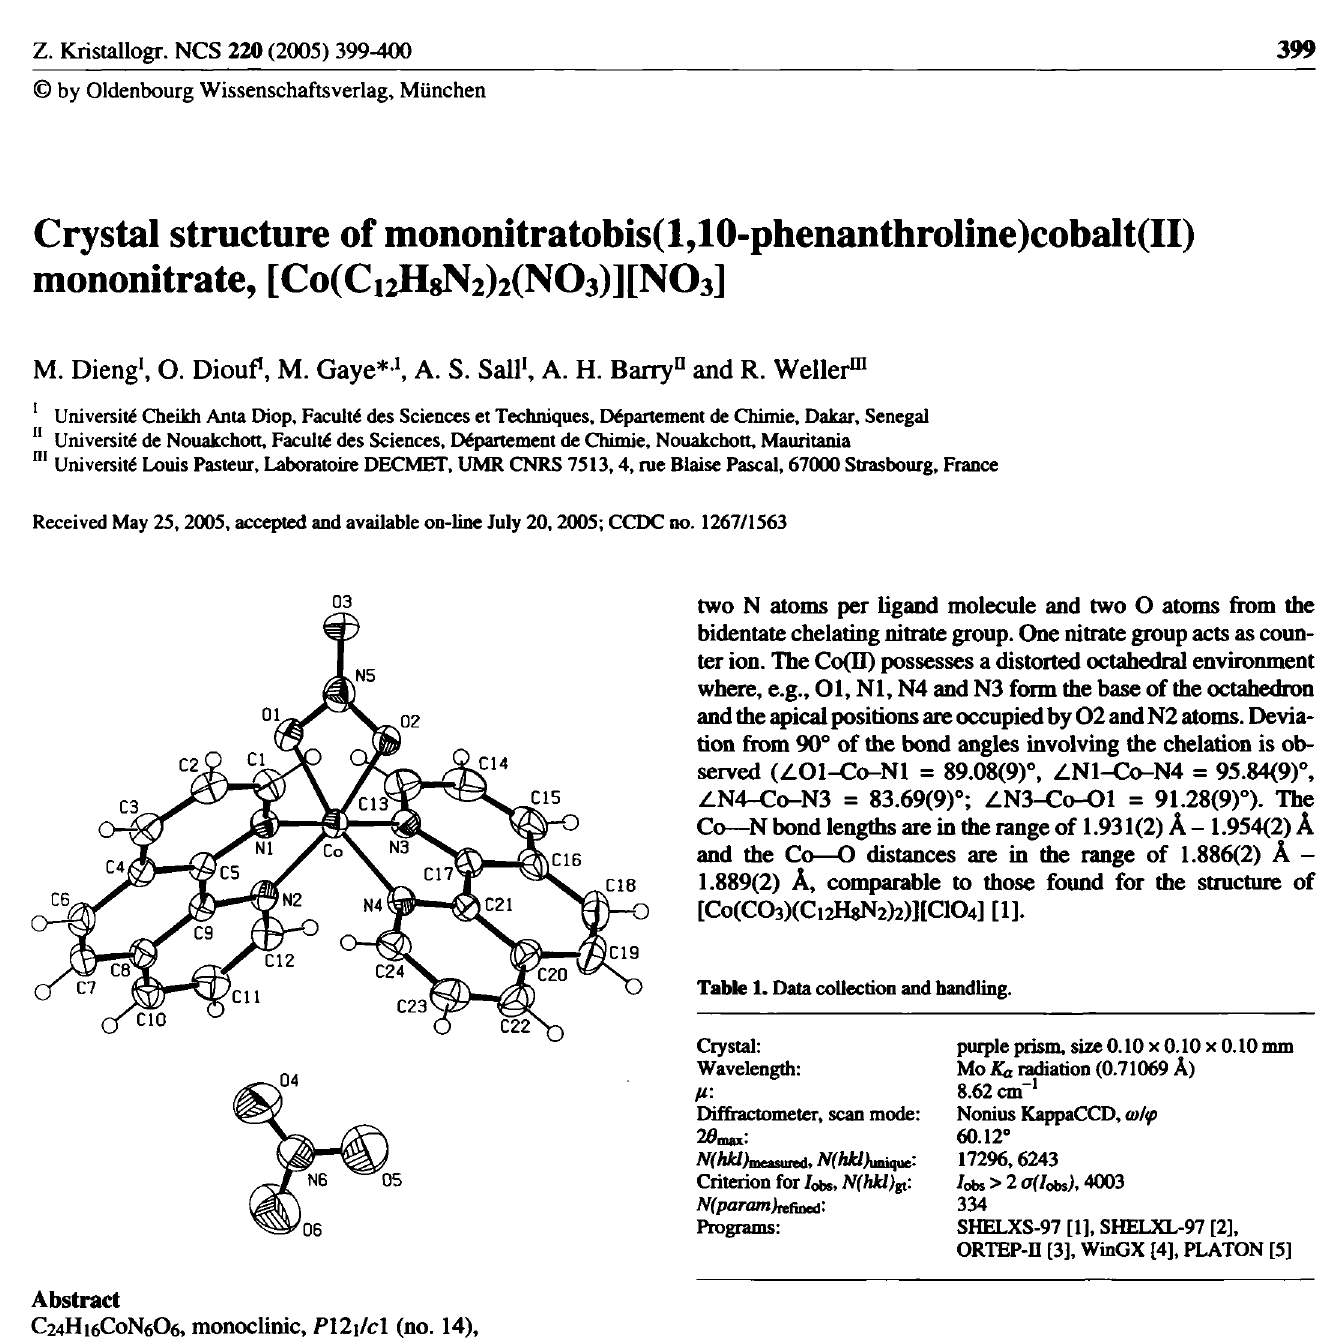
Table 2. Atomic coordinates and displacement parameters (in A 2